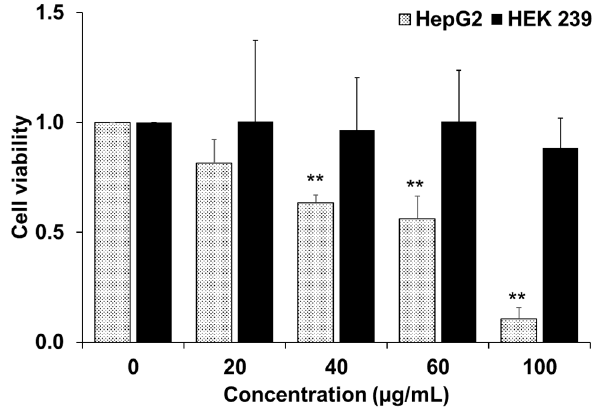
Figure 1. Cell viability of HepG2 and HEK 239 cells after being treated with different concentration of YLE. Data are presented as means ± standard deviation (S.D) ( n = 3); ** p < 0.01 vs. control group.